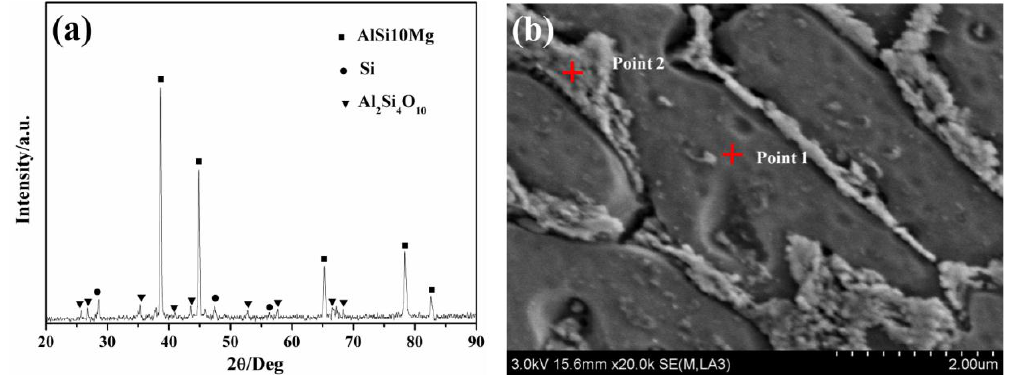
Figure 2. XRD spectrum ( a ) and the field emission scanning electronic microscope (FE-SEM) images showing the characteristic microstructure ( b ) of the SLM-processed composites at 150W and 400 mm/s.